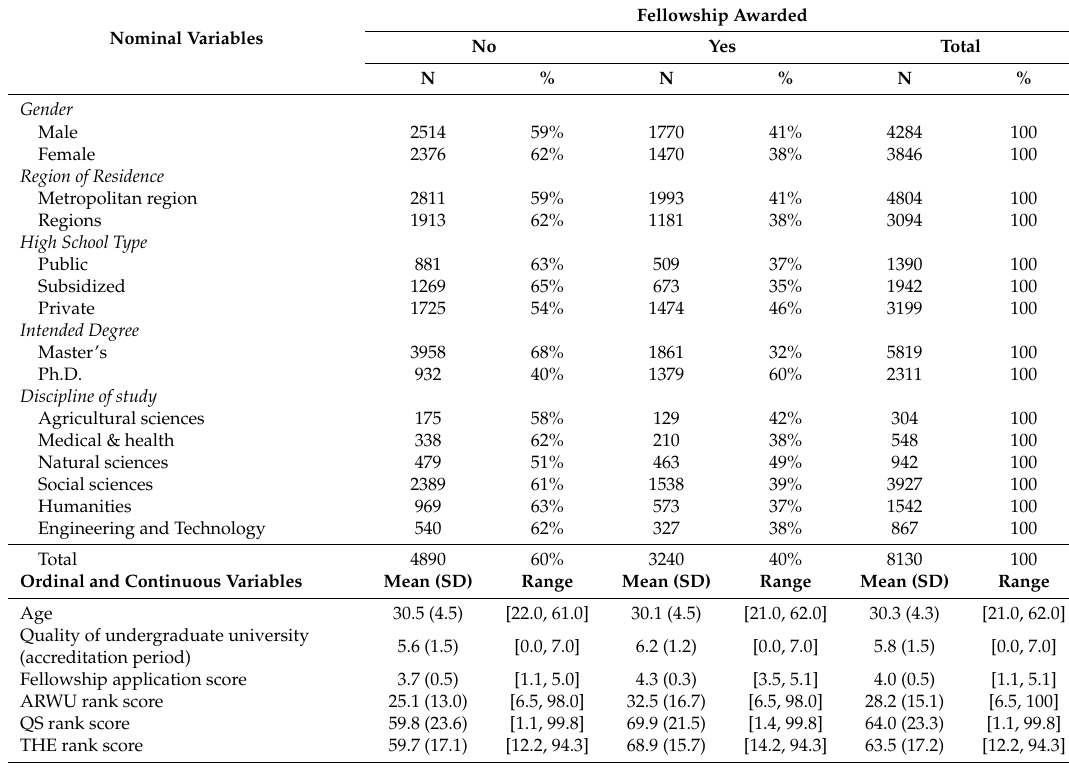
Table 1. Summary of the descriptive statistics of the